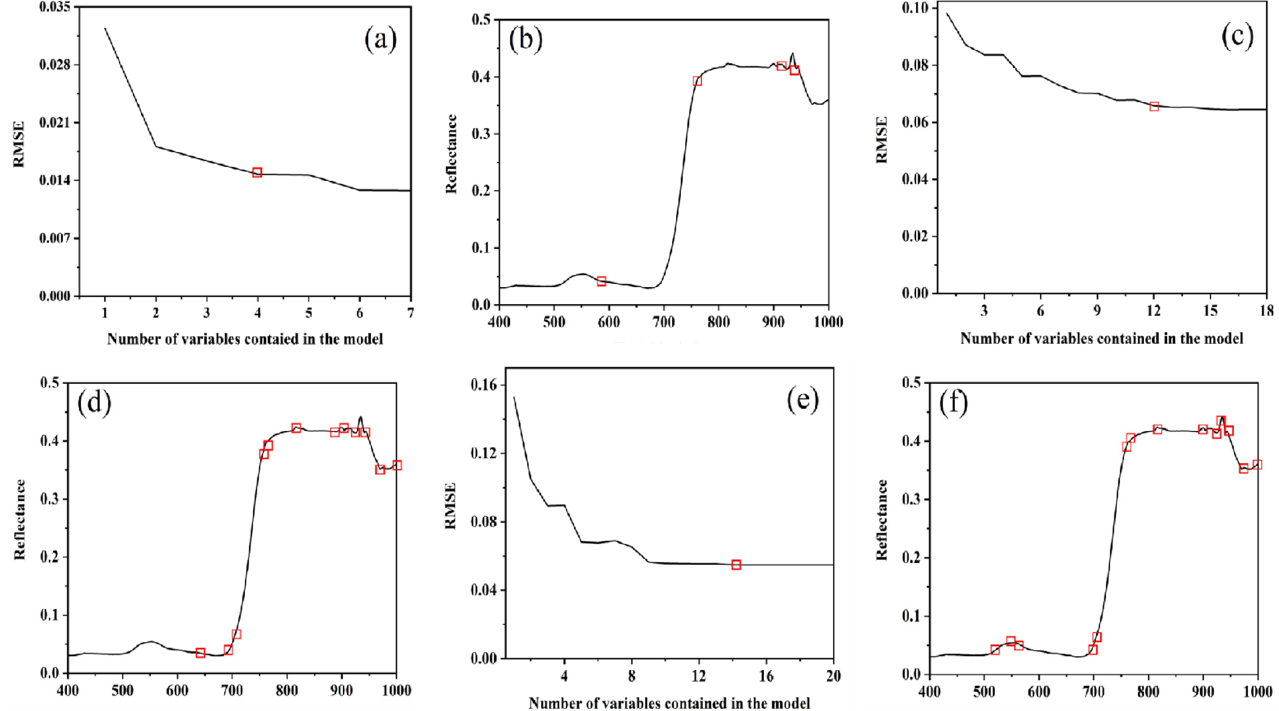
Figure 5. Reflectance spectra of the winter wheat canopy at the seedling stage: ( a – c ) show the number